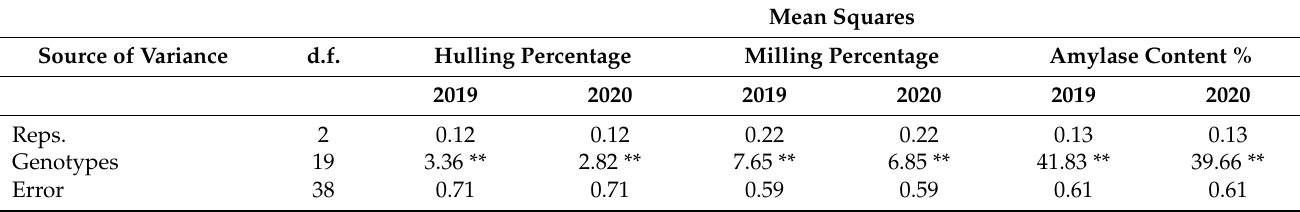
Table 5. Analysis of variances of grain quality of twenty rice genotypes over two